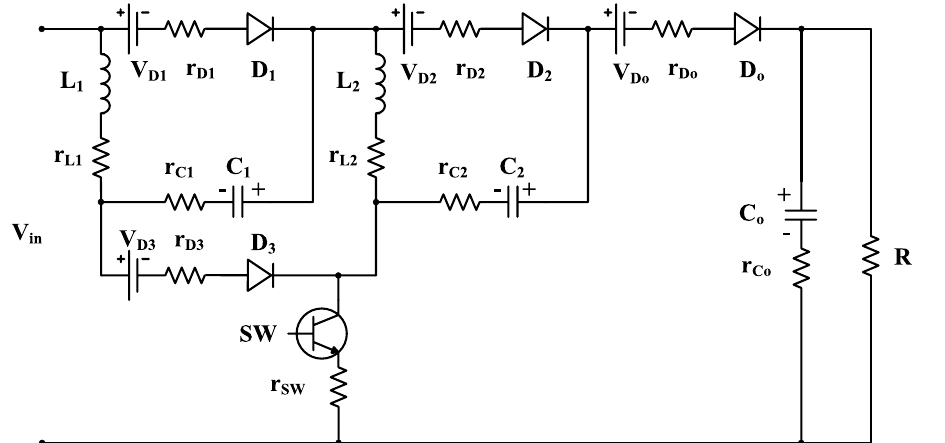
Figure 7. Equivalent model for the proposed circuit with parasitic